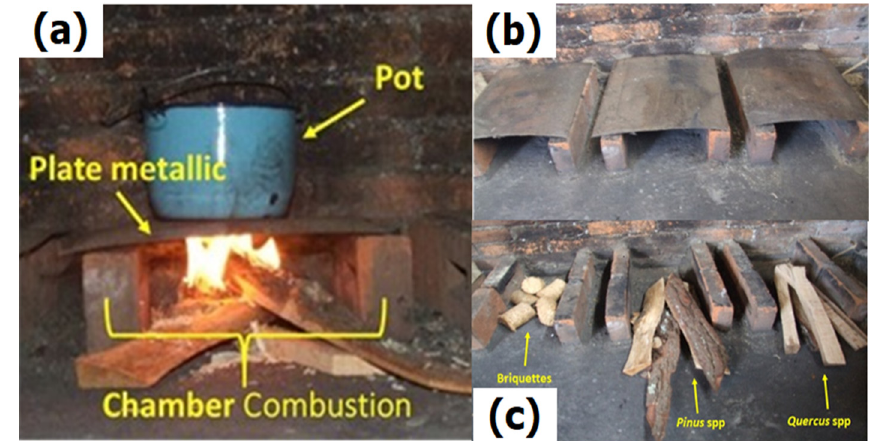
Figure 4. ( a ) Combustion test in the thermal chamber; ( b ) three thermally-insulated chambers; ( c ) three different types of fuel, including the briquettes.